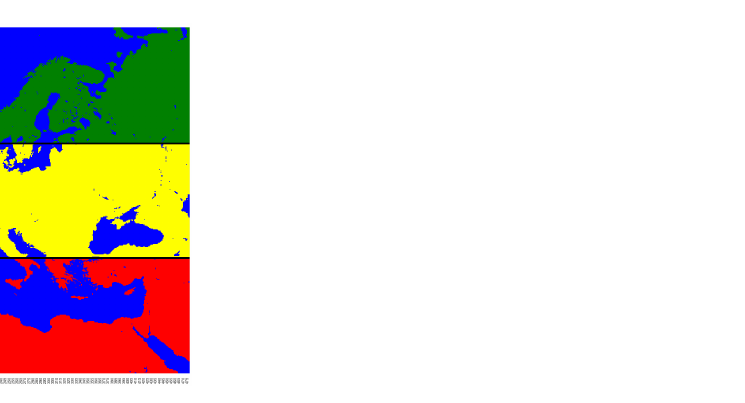
Figure A1. Three regions used to predict the effect of LC changes on surface temperature: northern (green), central (yellow), and southern (red)